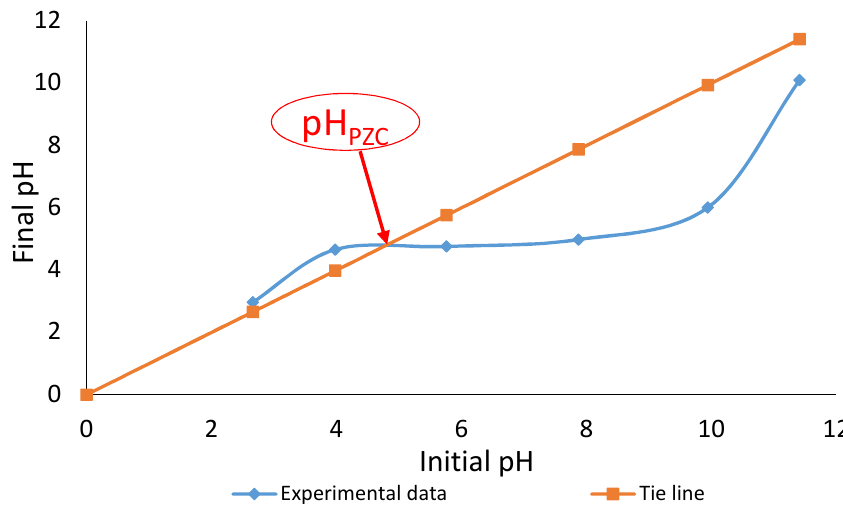
Figure 1. pH PZC determination technique using pH drift method.